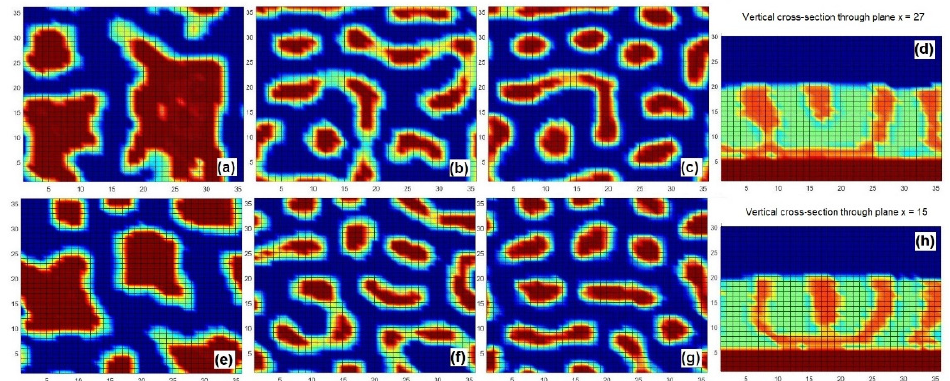
Figure 2. Horizontal cross sections through the planes z = 6 ( a , e ), z =12 ( b , f ), and z = 18 ( c , g ) and vertical cross sections through the planes x = 27 ( d ) and x = 15 ( h ) obtained with the following stick- ing coefficients: k AS = 0.6, k AB = 0.3 ( a – d ), k AS = 0.45, and k AB = 0.45 ( e – h ). coefficients: k AS = 0.6, k BS = 0.3 ( a – d ), k AS = 0.45, and k BS = 0.45 ( e – h